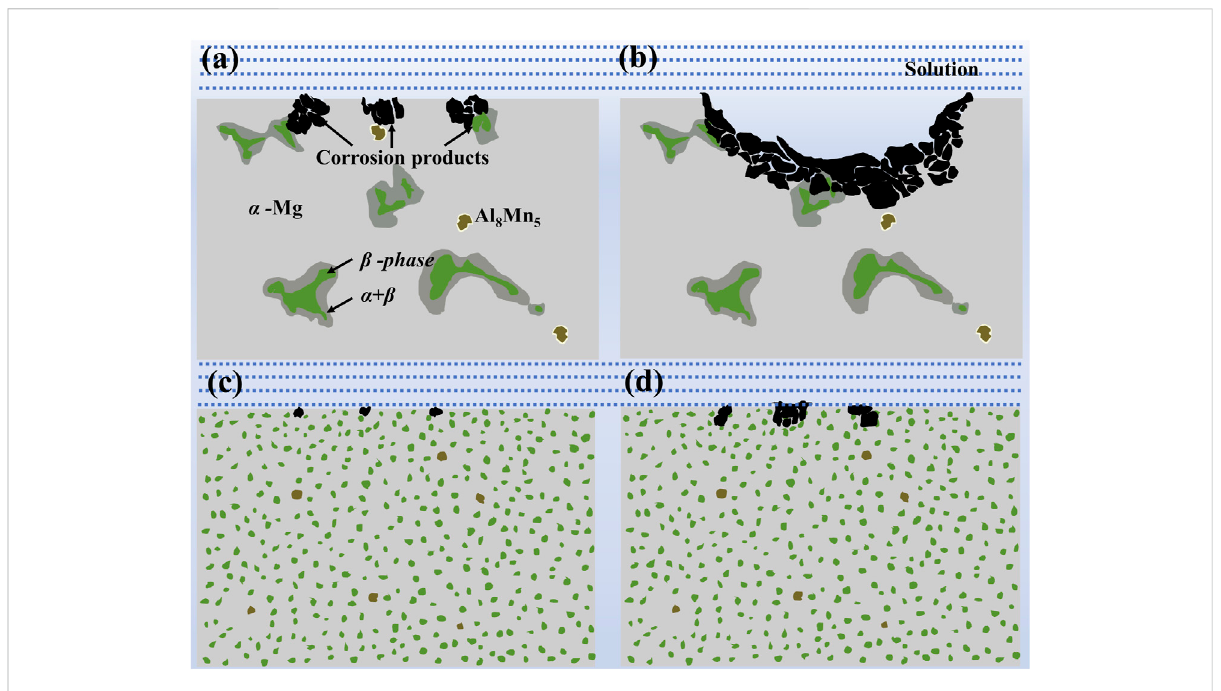
FIGURE 9 Schematic diagrams for the corrosion process of the as-received (A,B) and LSM treated (C,D) AM60B alloy (Liu et al., 2015).